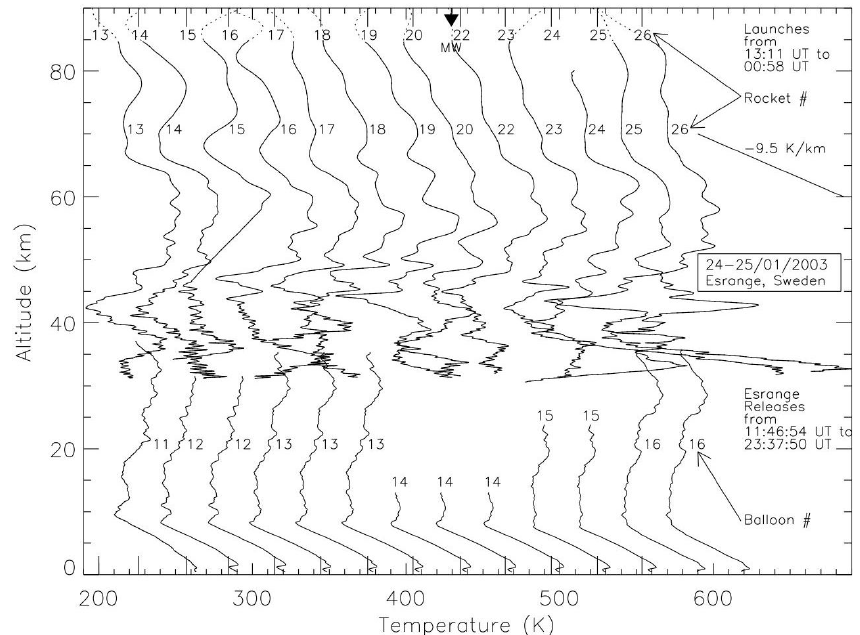
Fig. 13. Waterfall plot similar to Fig. 7, but for the 24–25 January 2003 sequence at Esrange. Table 4. Falling sphere and balloon information for Figs. 13 and 14. MaCWAVE Campaign January 2003, Esrange, Kiruna, Sweden. Date (UT) Falling sphere